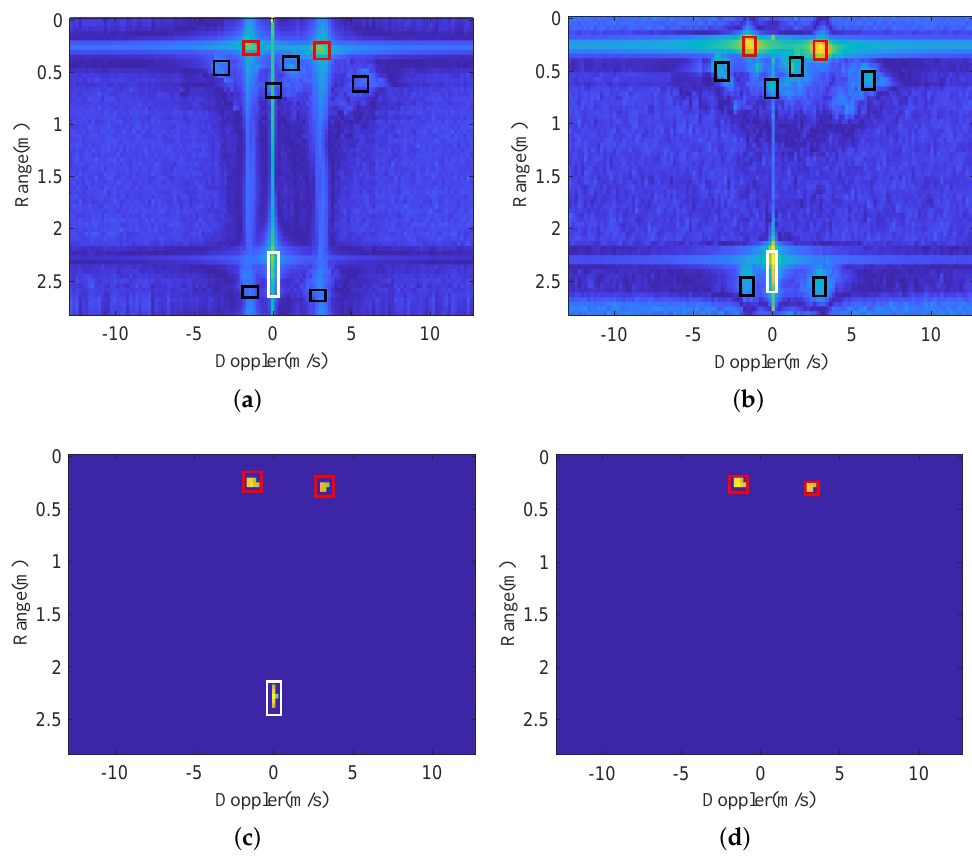
Figure 8. Effect of interference suppression for RDM. ( a ) Original. ( b ) With the added Hanning Window. ( c ) Dynamic interference suppression. ( d ) Static interference